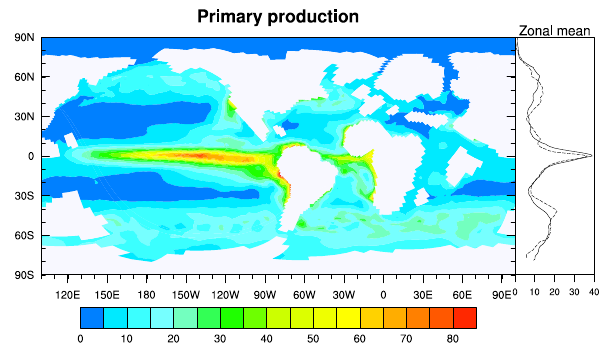
Figure 9. Annual mean primary production plotted as map and zonal average (both in mol Cm − 2 yr − 1 ). The zonal average plot Fig. 9. Annual mean primary production plotted as map and zonal average ( both in mol C m − 2 yr − 1 ). The shows the primary production for the late Paleocene (solid line) and zonal average plot shows the primary production for the Late Paleocene (solid line) and the pre-industrial the pre-industrial (dashed (dashed line).